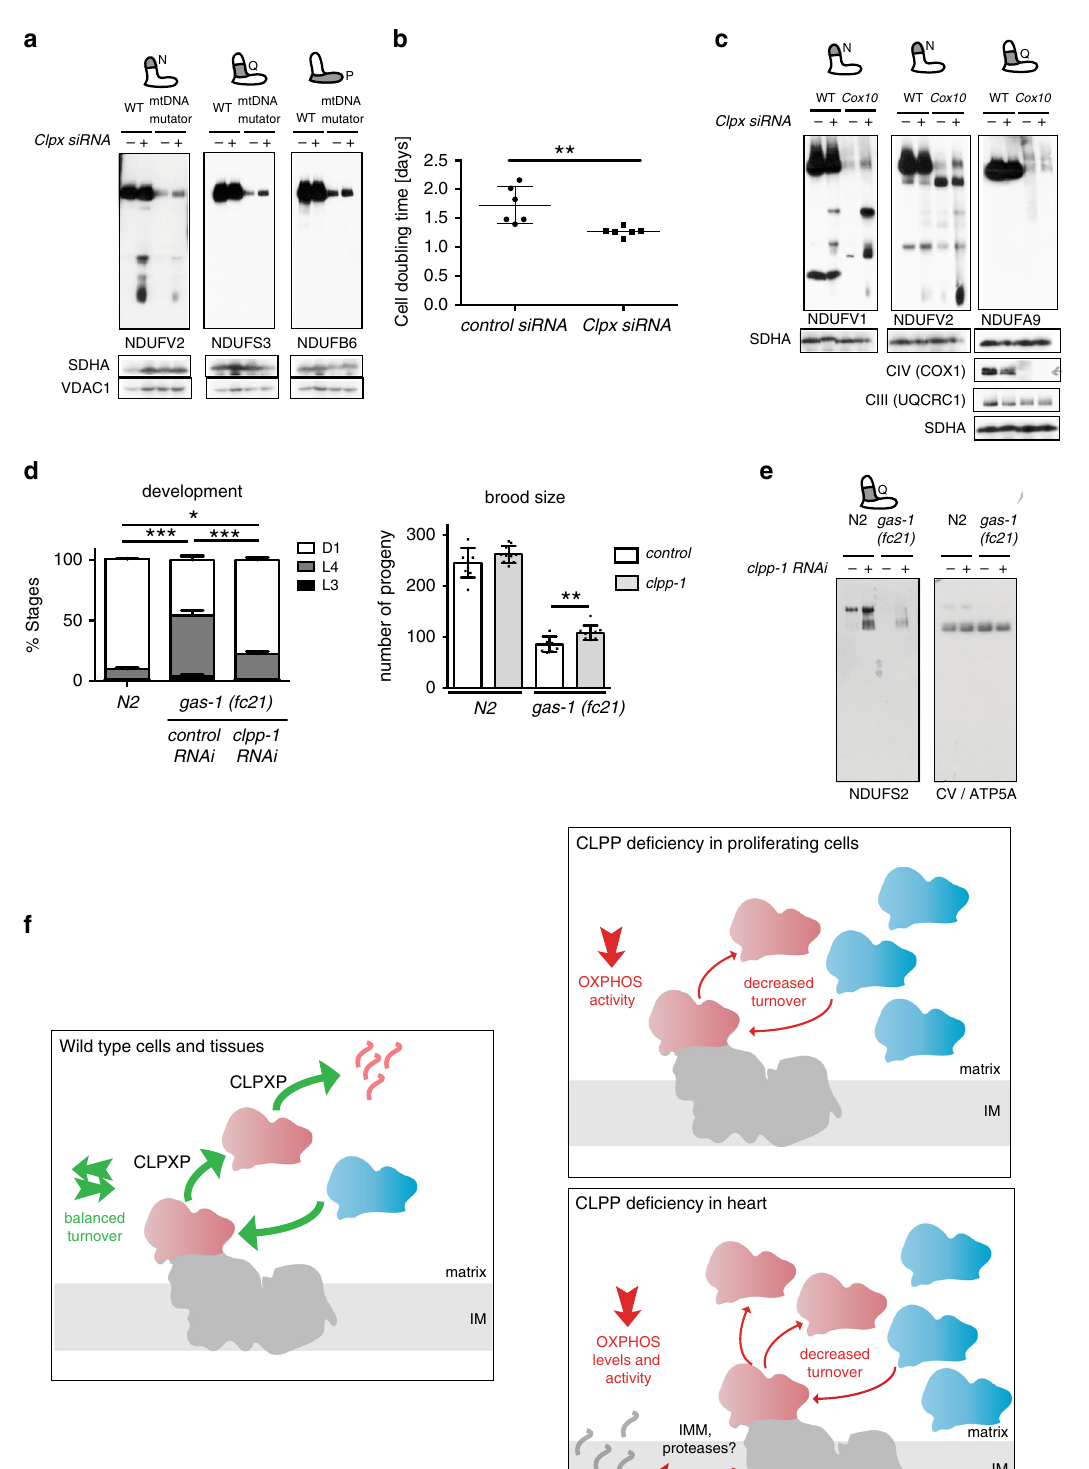
To determine the cell doubling rates, the equal numbers of cells were transfected with respective small-interfering RNA (siRNA) for 48 h, followed by cell number determination at the endpoint using the Countees Automatic Cell Counter combined with trypan blue staining. Development of new cell lines . A 20-bp guide sequence targeting DNA within the fi rst exon of Ndufb11 was selected from a published database of